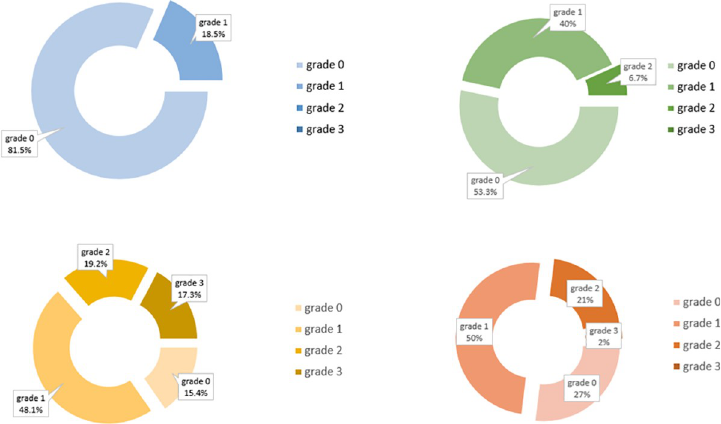
Fig 1. Meiboscore classification in control individuals (blue: lower eyelid; green: upper eyelid) and pterygium patients (yellow: lower eyelid; red: upper eyelid).